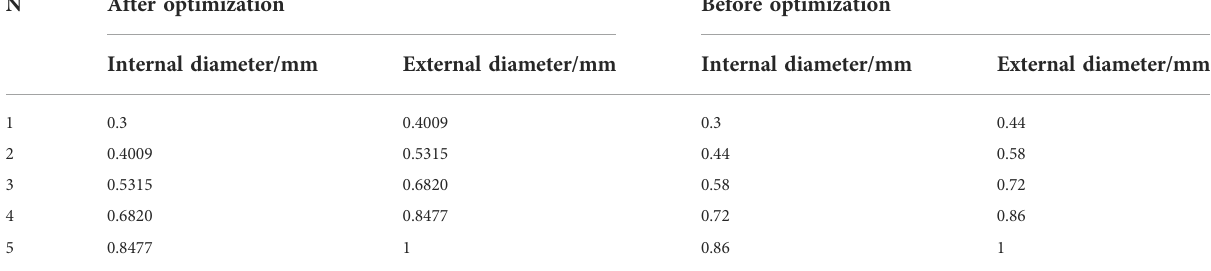
TABLE 2 Layer thickness of the cloak after and before optimization.